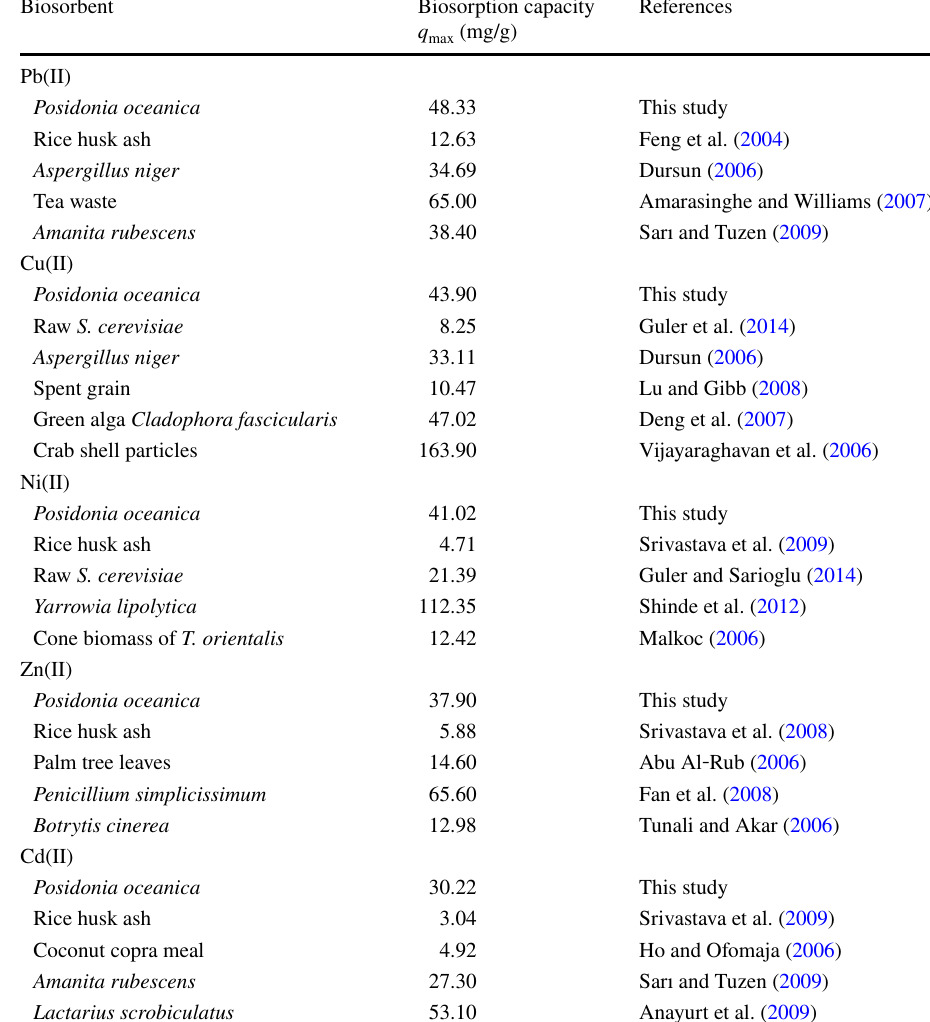
maximum biosorption capacities of heavy metals on various